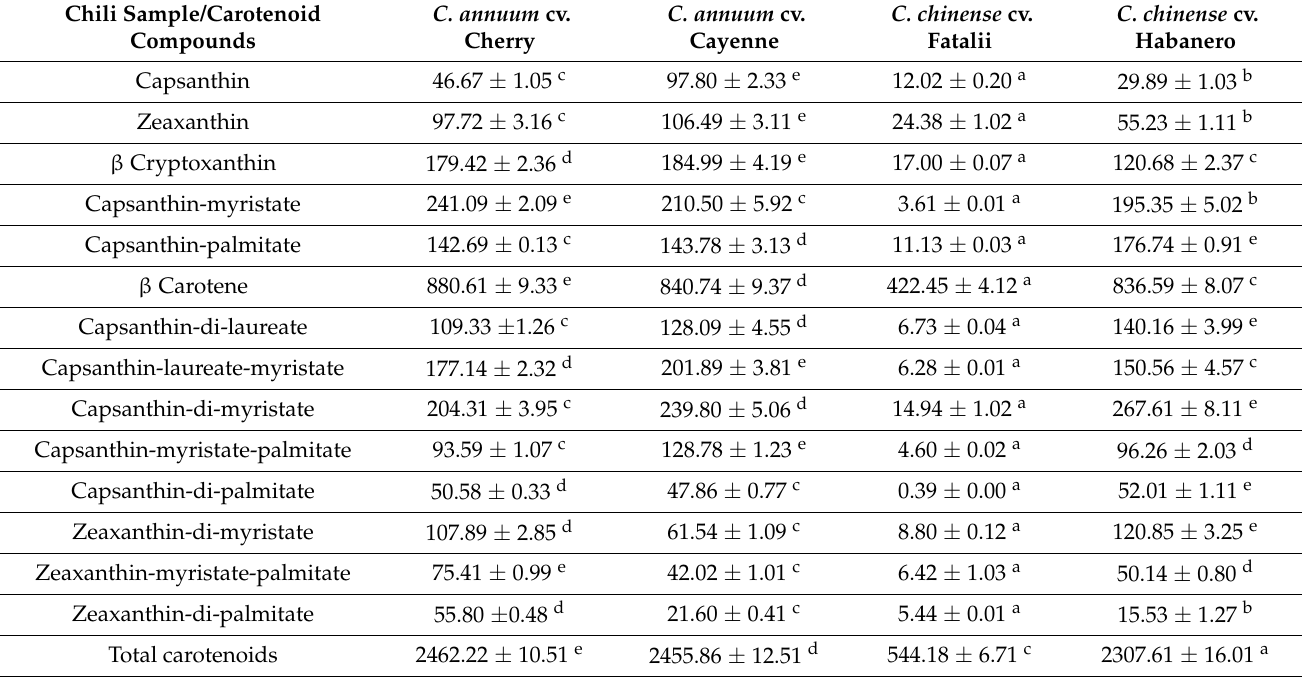
Table 2. Variation of carotenoid compounds in the samples of freeze-dried fermented chili